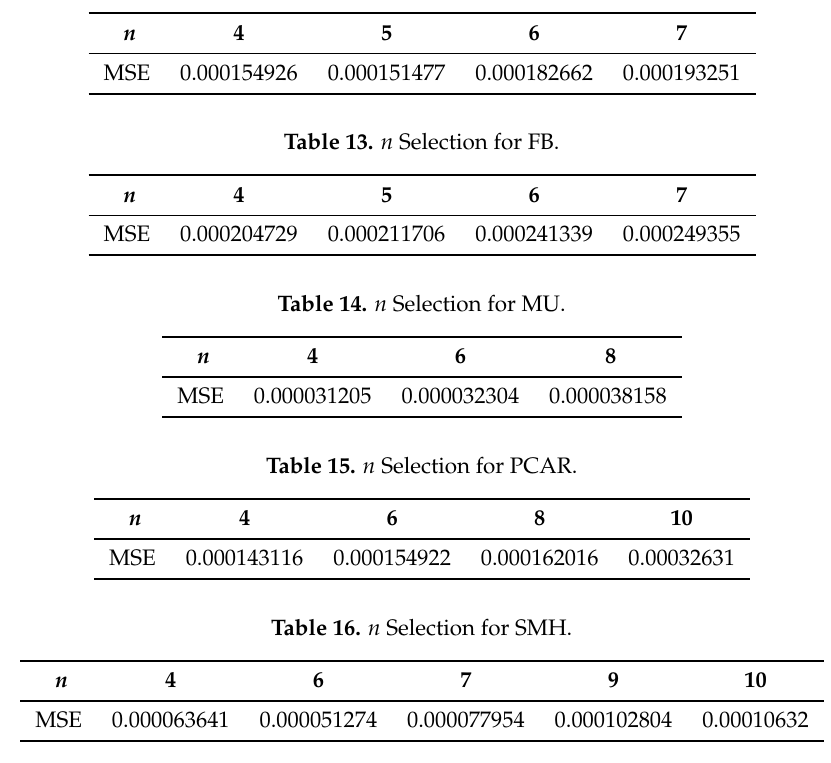
Table 12. n Selection for EBAY.